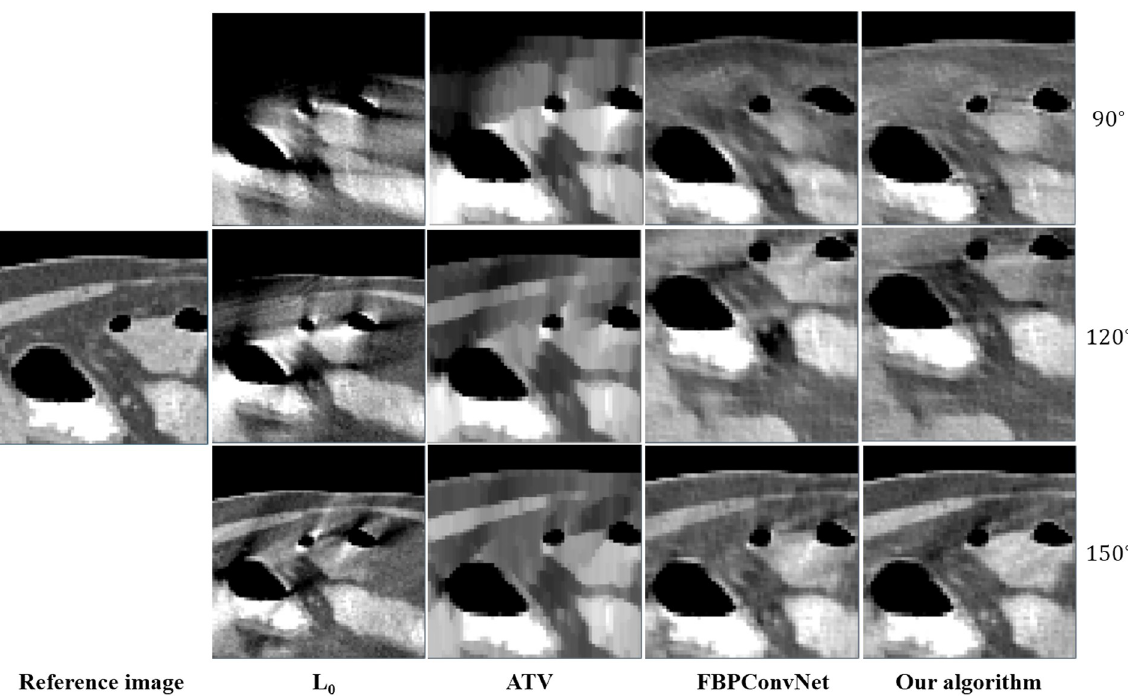
Fig 8. The zoom-in view of the ROIs for the Fig 6. The image on the first column is the ROI of the reference image. The subsequent columns are the ROIs of the reconstructed image for L0 method, ATV method, FBPConvNet method and our algorithm.